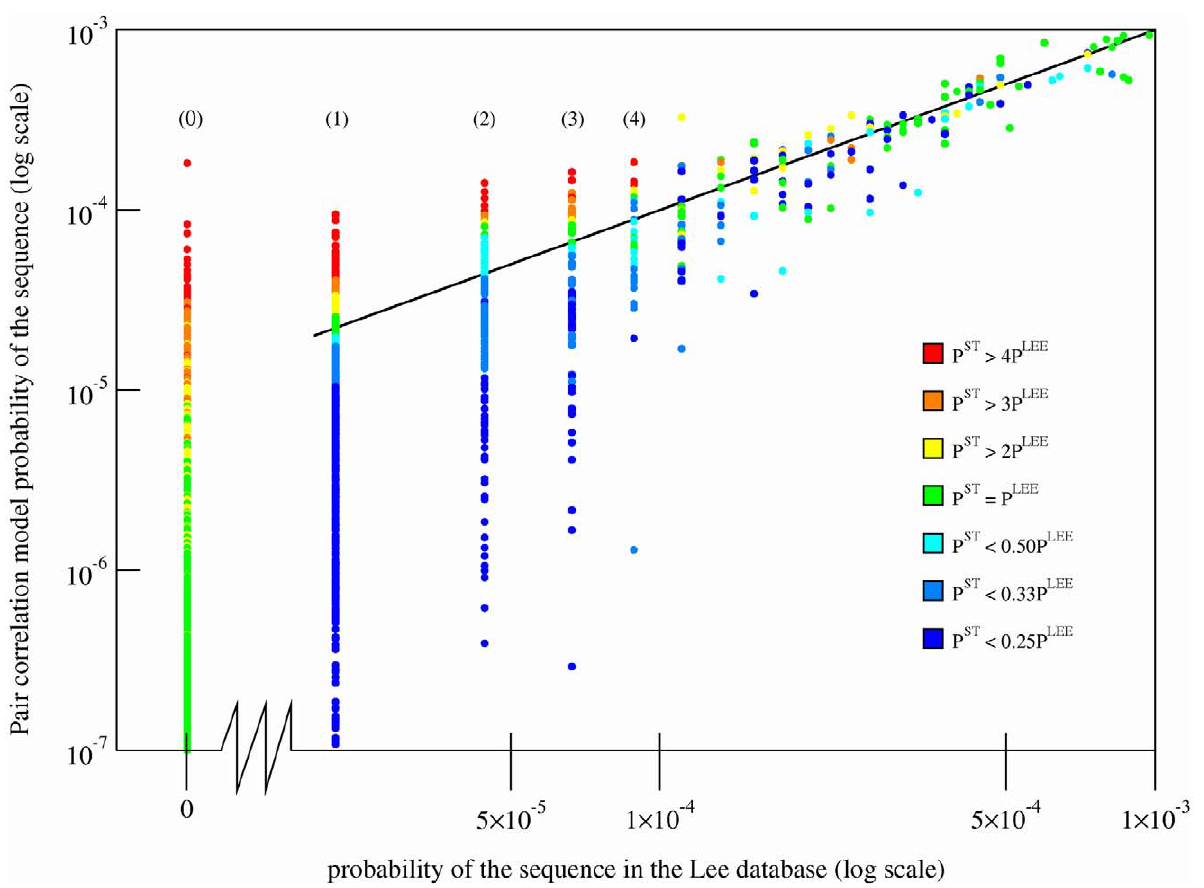
Figure 3. Comparison of the sequence probabilities in the tail of the Lee database and the pair correlation model with the sequence probabilities in the Stanford database. The probabilities of sequences under the pair correlation model, P 2 , predicted using the Bethe approximation, are plotted as a function of the sequence probabilities from the Lee database, P LEE . Sequences with a probability of 0 in the Lee database, i.e. unobserved sequences, are plotted to the left of the abscissa break. Every sequence is shaded using a color gradient corresponding to P ST = P LEE , which represents the number of times the sequence occurs in the Stanford database, relative to its probability in the Lee database. Sequences that occur frequently in the Stanford database as compared to the Lee database have a higher ratio and are shaded red, while the sequences that do not occur as frequently in the Stanford database as compared to the Lee database have a lower ratio and are shaded blue. Sequences that are shaded green have equal probabilities in both databases. Sequences unobserved in the Lee database (leftmost row in the graph), but observed in the Stanford database have a ratio that is artificially set to equal 4, which corresponds to the color red. Unobserved Lee sequences that are also unobserved in the Stanford database are shaded green because P ST ~ P LEE ~ 0 . Sequences with probabilities v 10 { 4 are shaded according to the average value of P ST = P LEE for a window of 10 sequences around the sequence of interest. Sequences with probabilities v 10 { 7 or w 10 { 3 are not shown. The indices (0), (1), (2), etc mark the locations of sequences observed zero, once, twice (etc) in the Lee database. Each dot corresponds to a unique sequence.